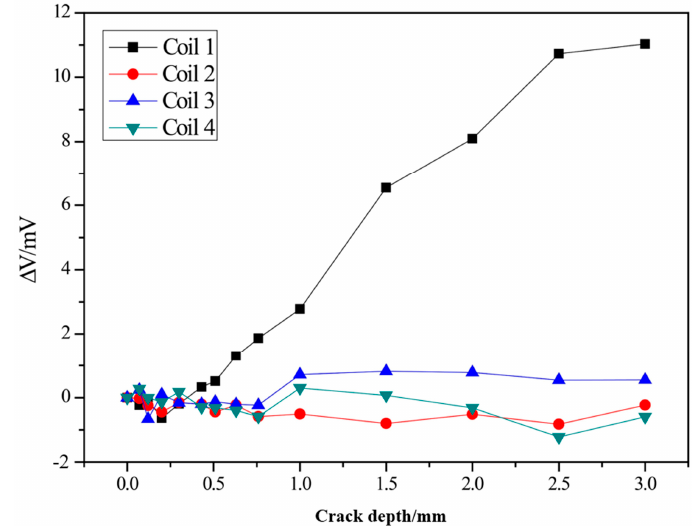
Figure 12. The experimental result of one-dimensional coil array sensing film.